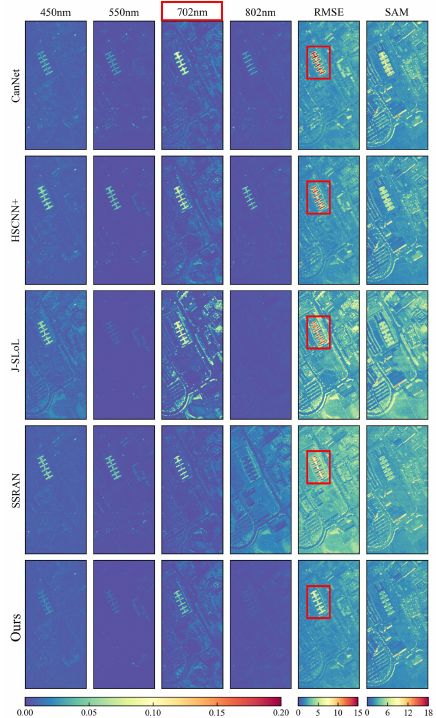
Figure 4. Visualization of SSR results of five methods using Pavia University dataset. Columns 1 to 4 show the absolute error of a single band. Columns 5 and 6 show the overall RMSE and SAM errors for all bands, the highlighted areas in the red rectangle are buildings.